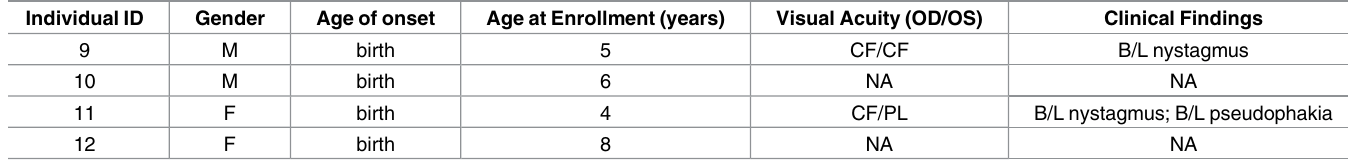
Table 2. Clinical characteristics of individuals of PKCC214who manifest symptoms of autosomal recessivecongenital cataracts. Individual ID